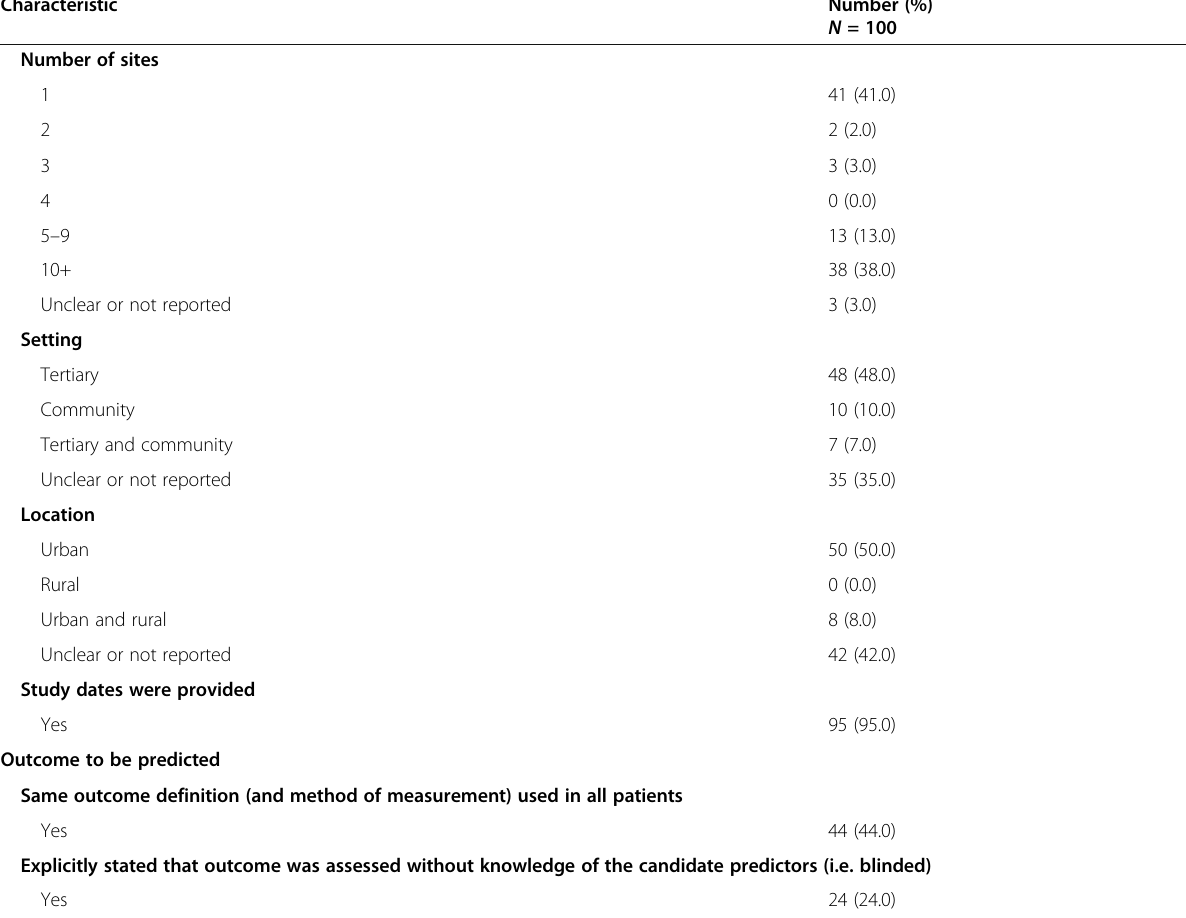
Table 2 Reporting of essential items applicable to both derivation and validation studies